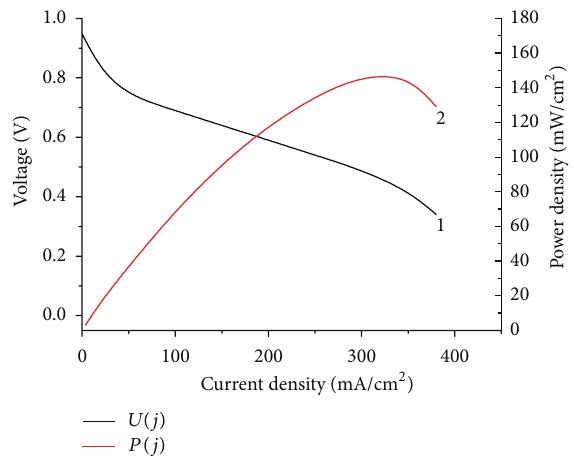
Figure 5: Electrical characteristics of the fuel cell based on carbon nanotube/metallic particle hybrids formed on porous stainless steel pellets as electrodes. 1 𝑈(𝑗) ; 2 𝑃(𝑗)